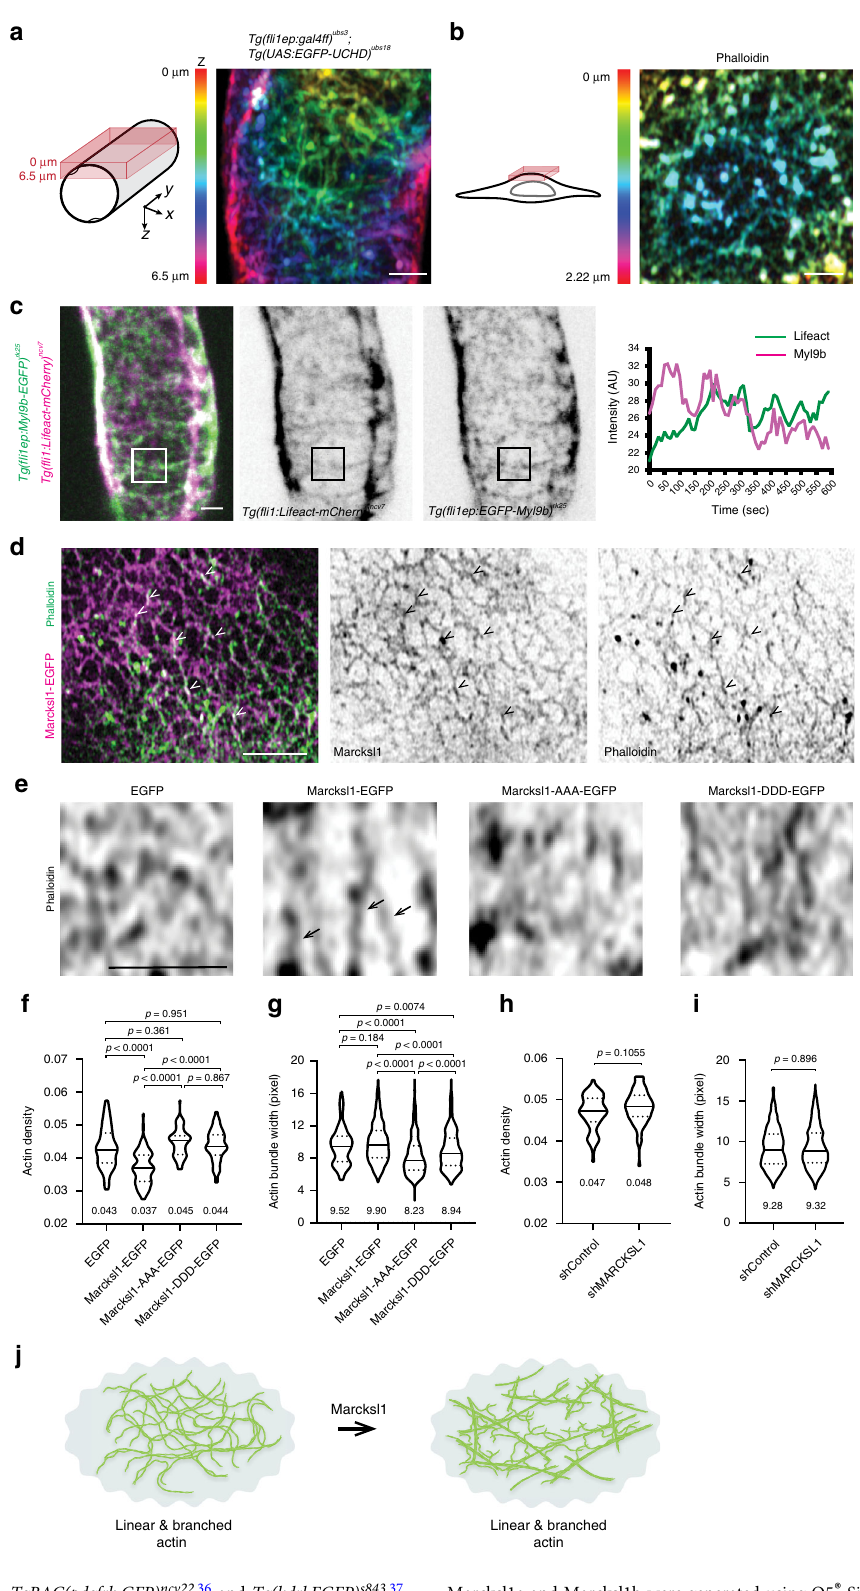
Marcksl1a and Marcksl1b were generated using Q5 ® Site-Directed mutagenesis kit (NEB). shRNA containing vectors were constructed by ligation of shRNA sequence between the Eco RI and Pme I sites downstream of the U6 promoter of modi fi ed pEGFP-U6 vector 39 (a gift from Zuoshang Xu, Addgene plasmid #19799). Target sequence for human MARCKSL1 is 5 ′ -GTGTGAACGGAACAGATGATG-3 ′ . The scrambled shRNA sequence 5 ′ -GAGTCATGGGTCAGTTATATG-3 ′ was designed as a mismatched sequence (underlined) of MARCKSL1 shRNA. Vectors